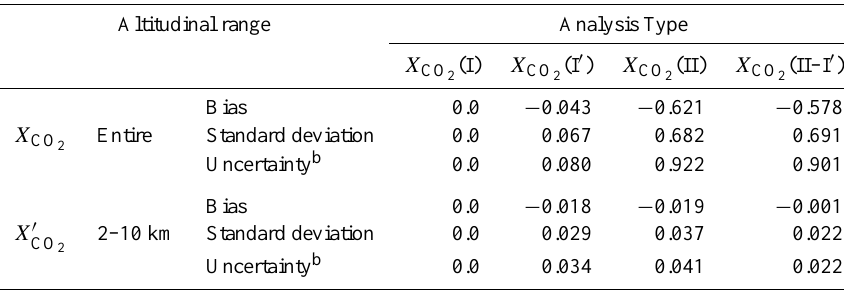
Fig. 2. Time series of X CO and X 0 from type I analysis over Narita using CONTRAIL data from January 2007 to May 2008. Data from CO 2 2 493 flights by five airliners were analyzed. X CO (blue marks and solid blue line) were numerically integrated to cover the entire altitudinal 2 range, i.e., from the ground level to the lower thermosphere (85km), and for X 0 (red marks and dotted red line) over the altitudinal range CO 2 of 2–10km. Data on 16 August 2007 were not included in the fit. Daily averaged X CO using the scaling retrieval algorithm by FTS are 2 plotted by green marks. Table 2. Relative uncertainties of X CO based on type I analysis (ppm) a . To show small relative values, the uncertainties are given to 3 2 decimal